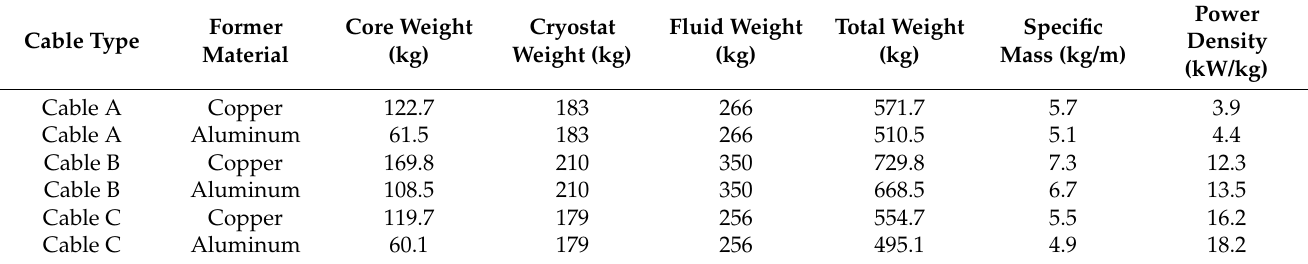
Table 6. Analyzing the specific mass and power density of the optimally designed HTS